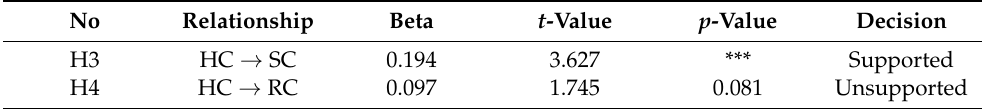
Table 7. Relationship between human, relational and structural